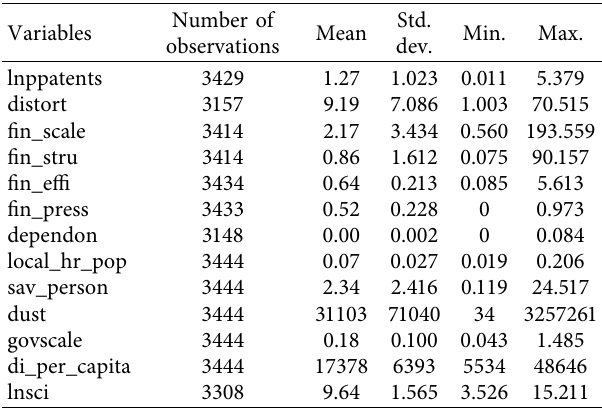
Table 2: Baseline regression results. Table 1: Descriptive